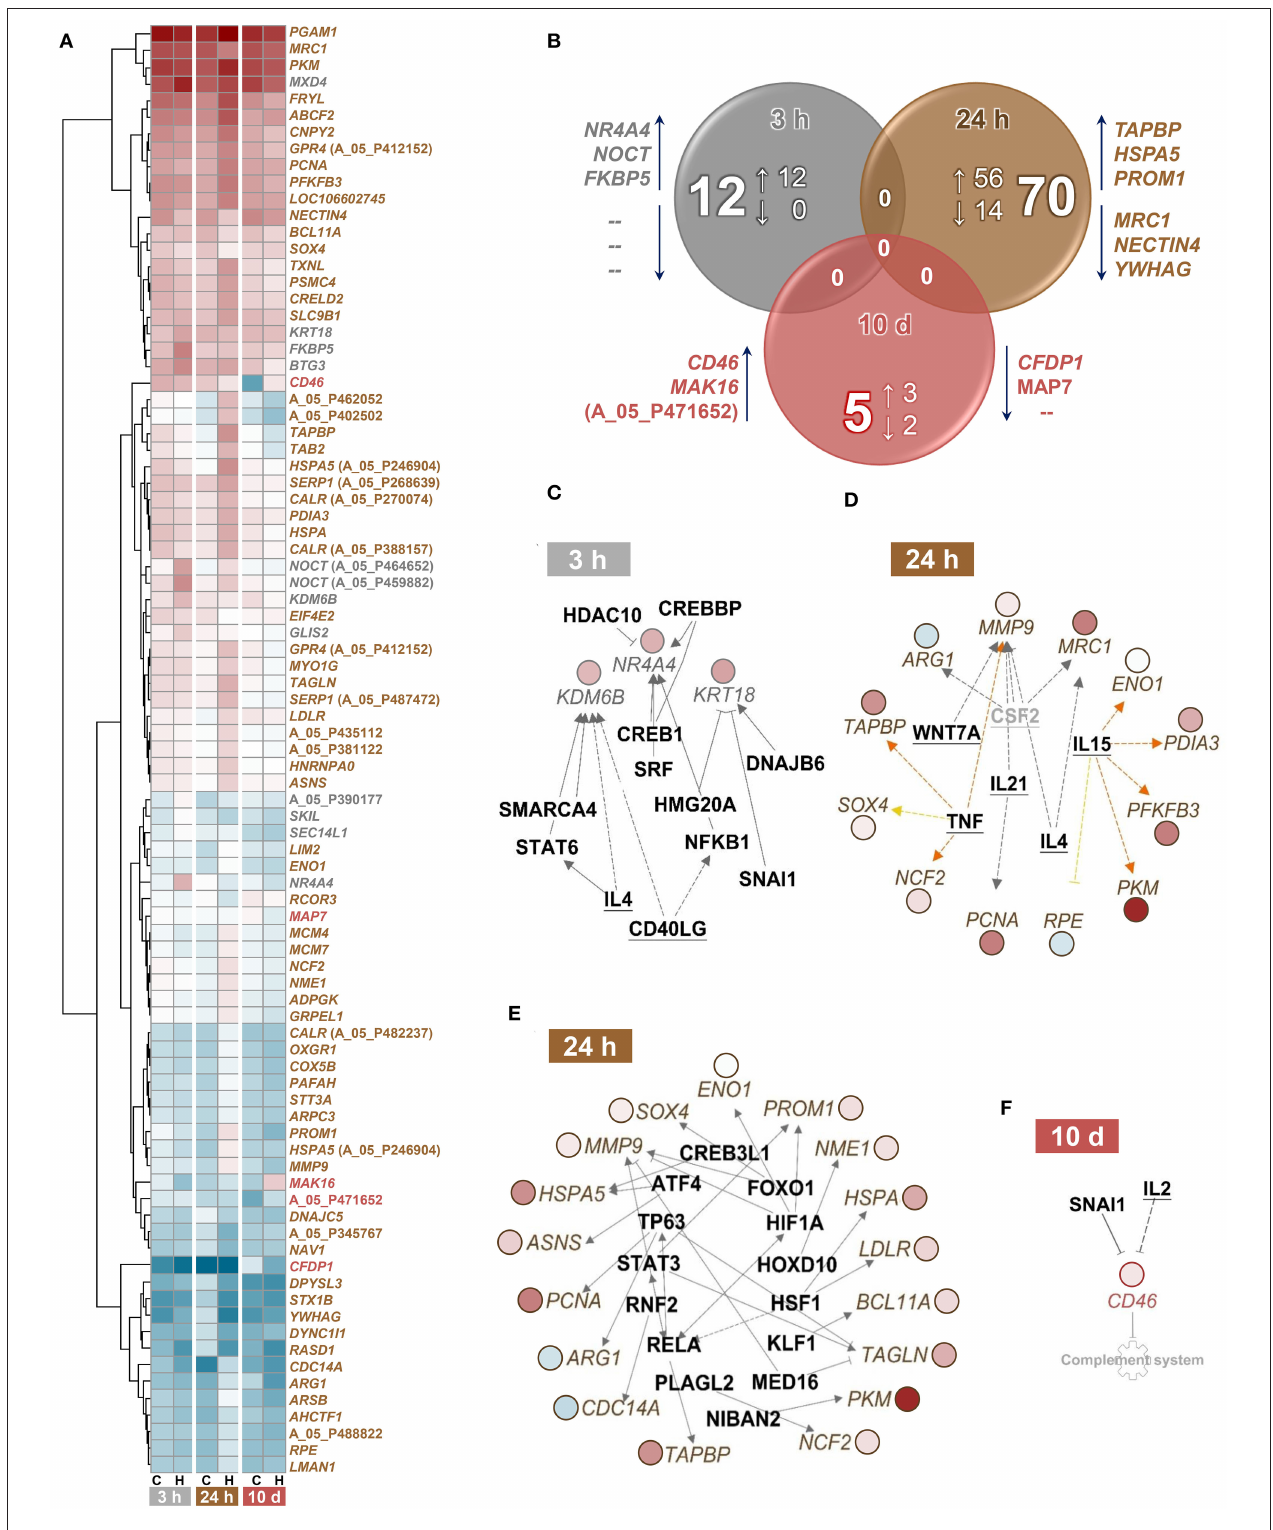
FIGURE 4 | Classification of differentially expressed (DE) genes in treated vs. control maraena whitefish. (A) Hierarchical representation of DE features ( q < 0.01; FC